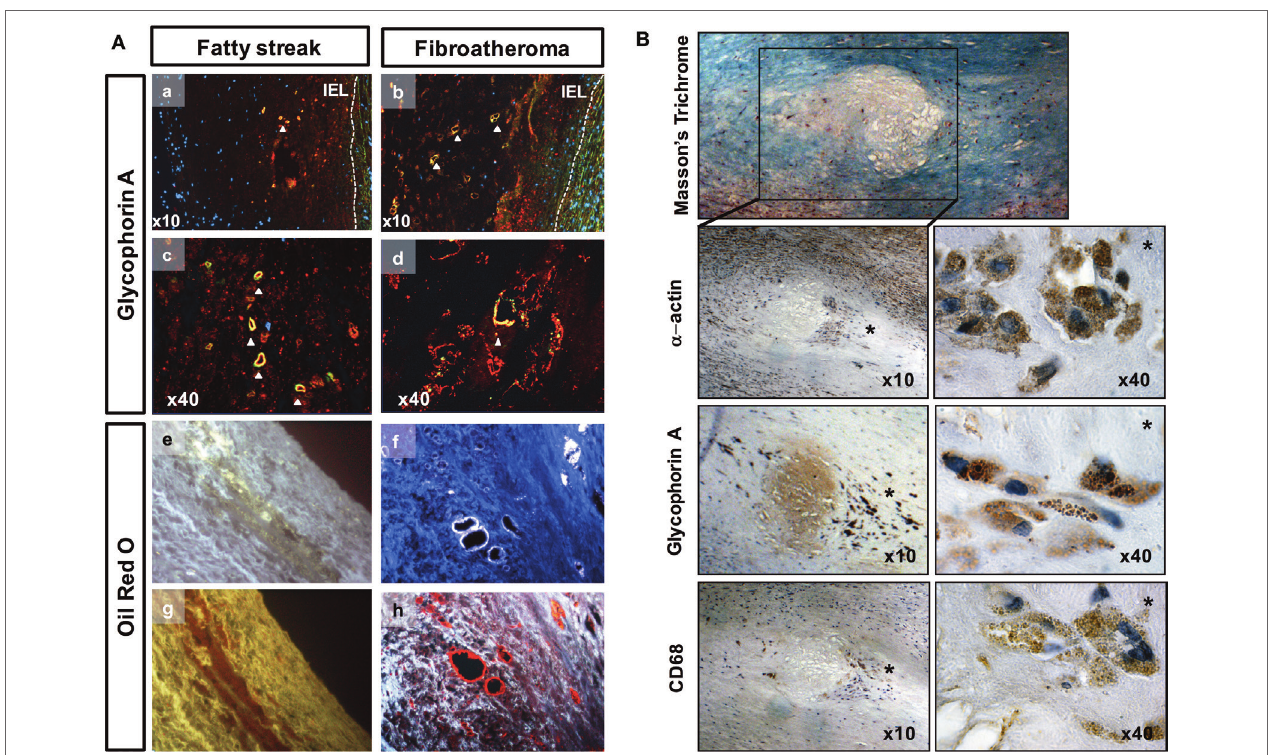
FigUre 3 | Red blood cell phagocytosis in early-stage atheroma. (a) Detection of ceroids (autofluorescence) and glycophorin A (red) in the tunica intima of fatty streaks (FSs) and in lipid core of fibroatheromas (FAs) corresponding to high magnifications of pictures 2Aa (FS), b (FA), respectively. Granular and ring-shaped ceroids (merged yellow) co-localized (a–d) with glycophorin A immunostaining. Autofluorescent granular ceroids (e) and ceroid rings (f) were detected in the tunica intimas of FS and Fas, respectively (white autofluorescence at a wavelength of 350 nm). The ceroids were also characterized by their ability to bind ORO (g,h, red staining). IEL, internal elastic lamina. (B) Photographs of a lipid core surrounded by phagocytes in the shoulder region (*) of an initial plaque (Masson’s trichrome). These phagocytes are α -actin + , glycophorin A (Gly-A) + , and CD68 + . Gly-A and CD68 specifically localized to cytosolic granules in the phagocytes (40 ×